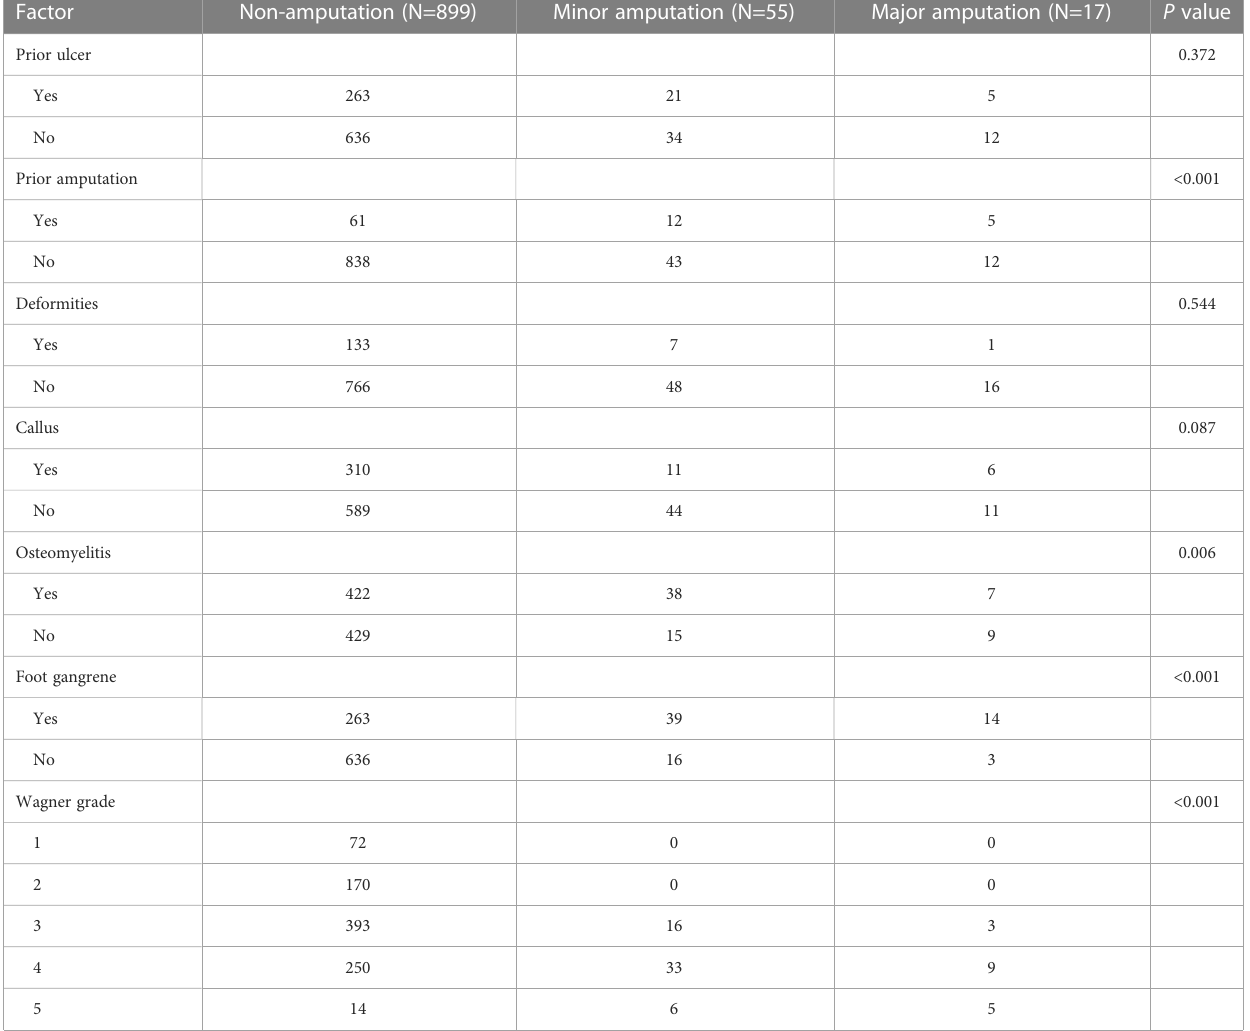
TABLE 3 Comparison of foot-related characteristics among the non-amputation, minor amputation and major amputation